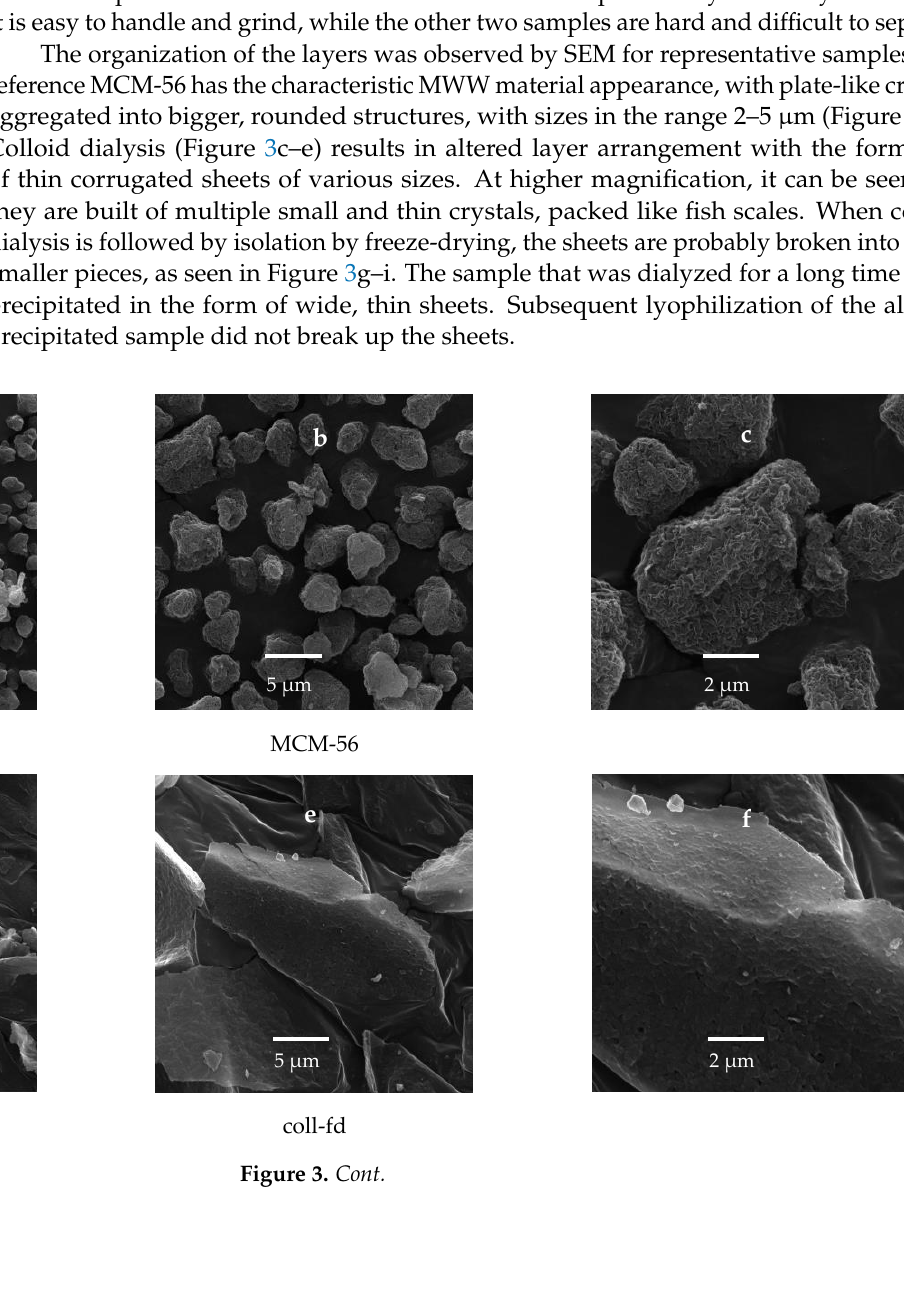
Figure 2. N 2 adsorption–desorption isotherms for zeolites under study: ( a ) MCM-56 ion-exchanged and dialyzed, ( b ) col- loids precipitated with ethanol, ammonium nitrate and freeze-dried (lyophilized), ( c ) colloids purified by dialysis and subsequently precipitated. All samples were additionally calcined before the isotherm measurements.